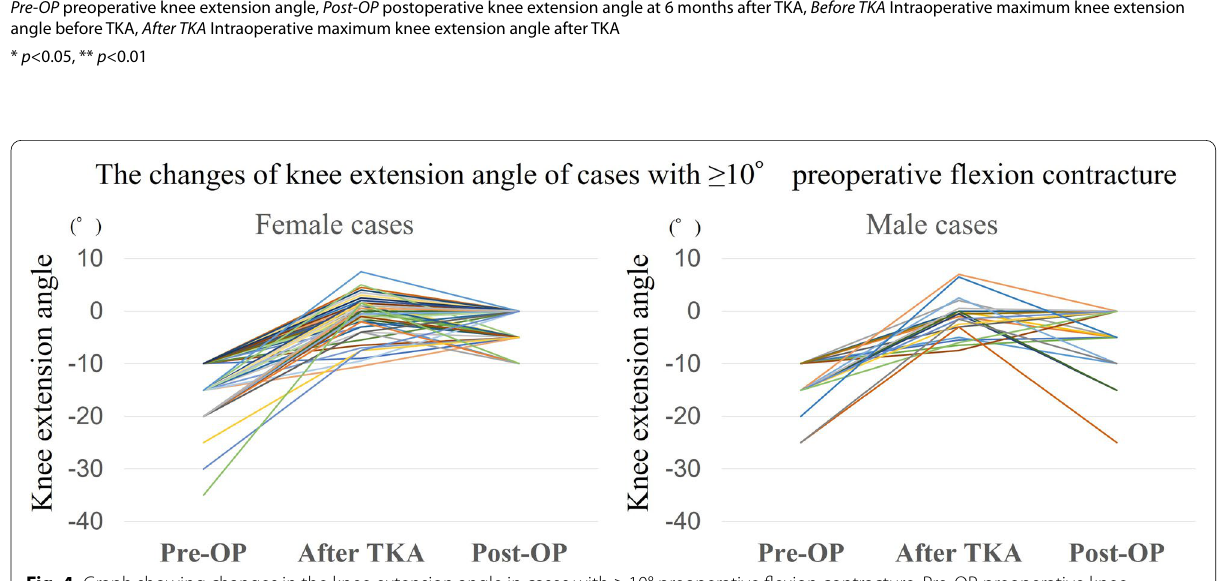
Fig. 4 Graph showing changes in the knee extension angle in cases with extension angle; After TKA, Intraoperative maximum knee extension angle after TKA; Post-OP, postoperative knee extension angle at 6 months after